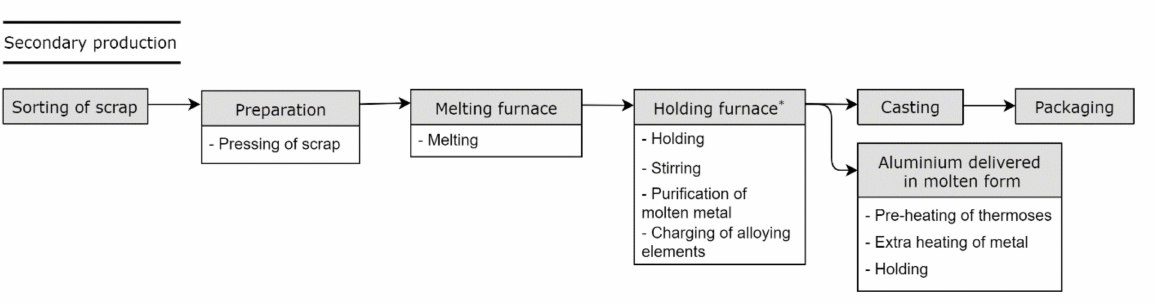
Figure 5. Production processes associated with the secondary production of aluminium. * This is sometimes called a